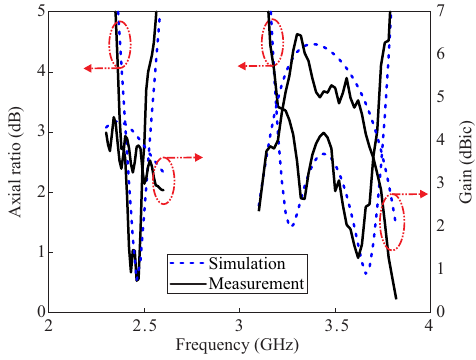
Figure 9. Comparative simulated and measured ARs and Gains of the proposed